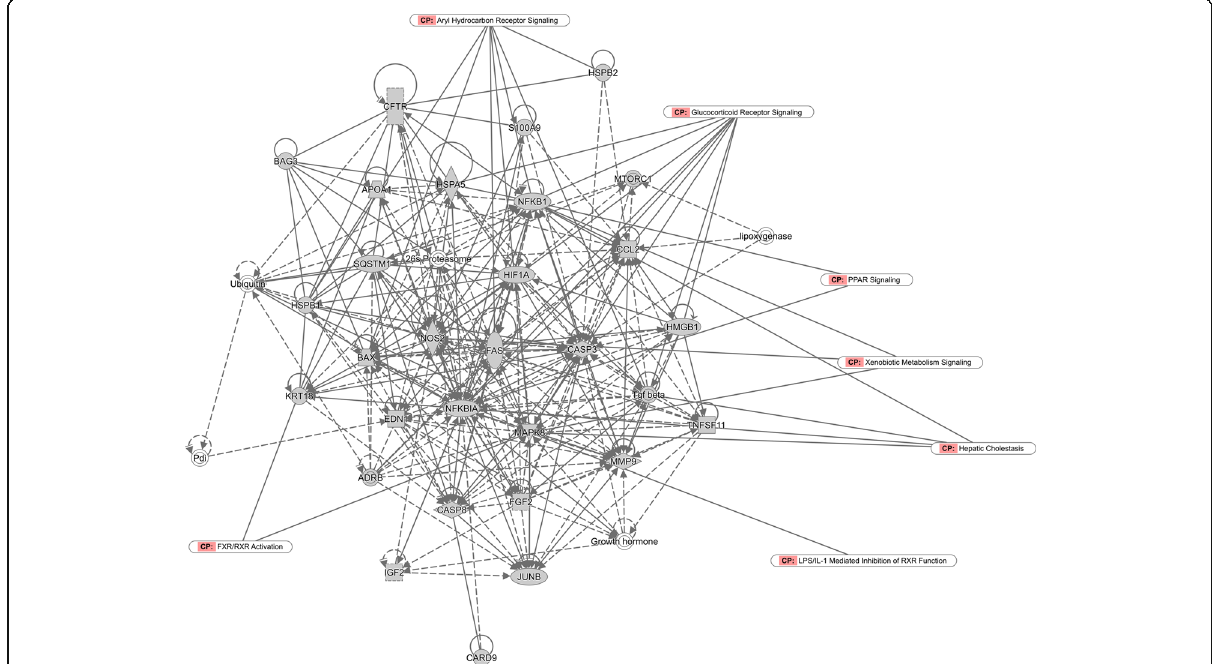
Fig. 3 The molecular network of